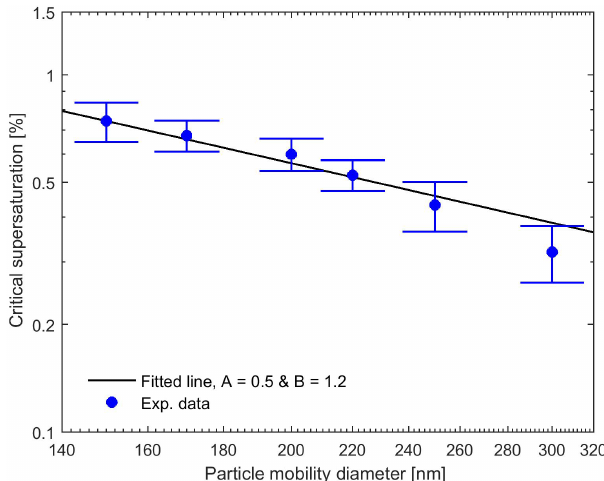
Figure 3. Vacuum aerodynamic diameters ( d va ) from organic and carbon ion signals from SP-AMS for particles containing BC coated with various organic compounds. The inset represents mass size distribution vs. d va extracted from BC and organic ion signals for monodispersed 200nm BC particles coated by 27nm levoglucosan. The coating thickness was estimated from the mobility size mea- surements by SMPS.